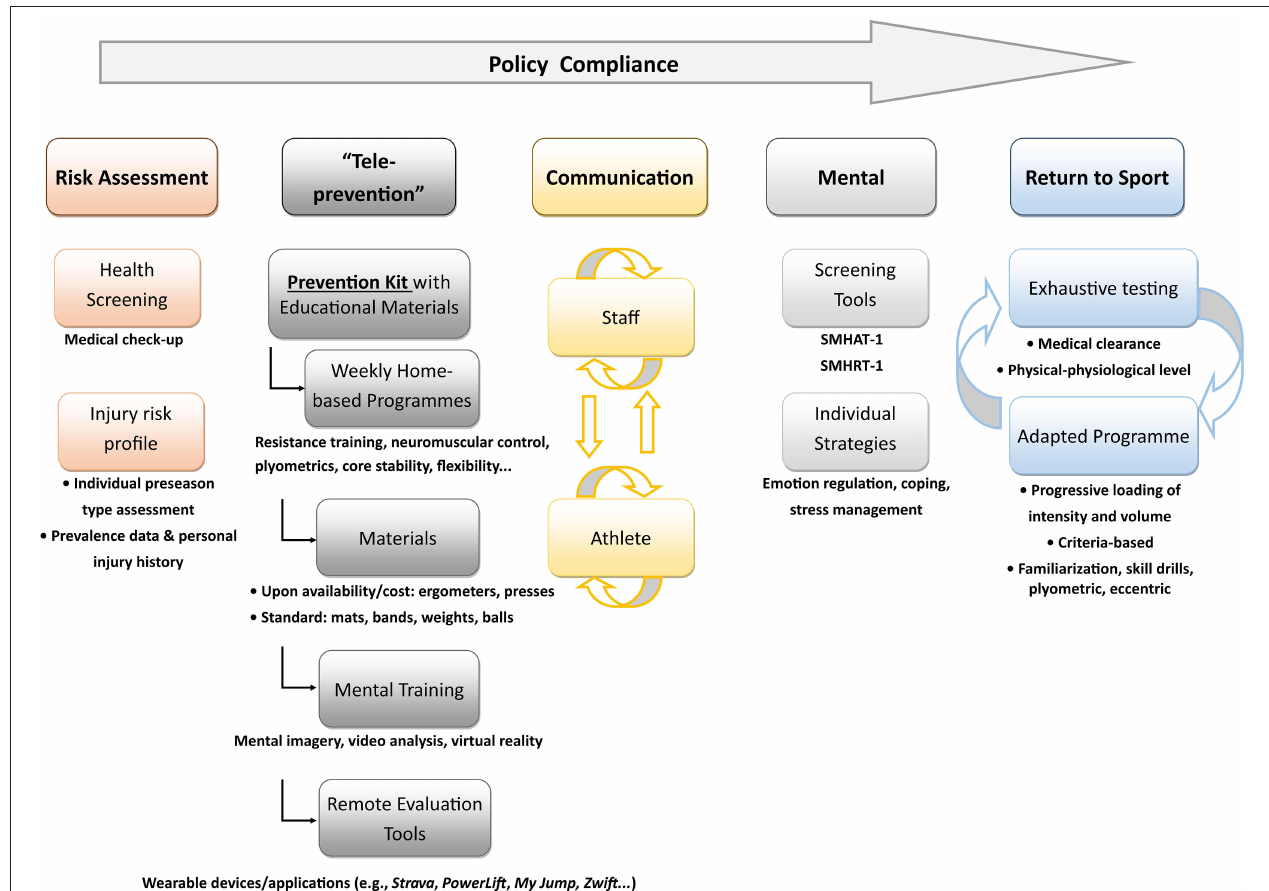
FIGURE 1 | Checklist of tools and procedures for injury prevention that should be readily available before a lockdown-like